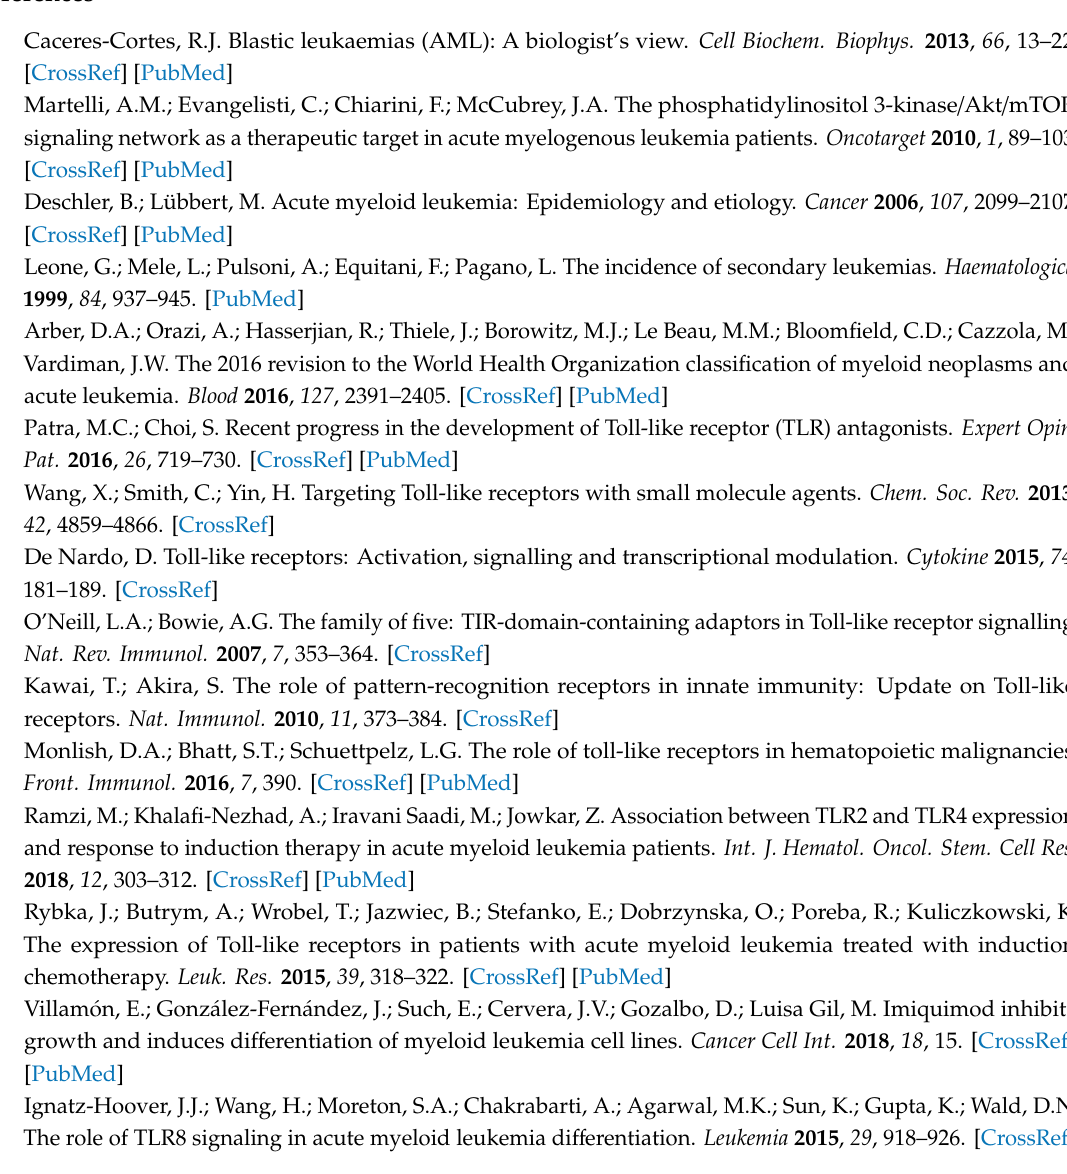
Figure S1: Patient survival dependent on response towards general TLR targeting, Figure S2: Basal mediator secretion levels for the 83 AML patients, Figure S3: Change in proliferation for the 10 test patients whose cells were exposed to di ff erent concentrations of TLR ligands, Table S1: Median concentration increase in the secretion of 19 soluble mediators as a result of targeting with four di ff erent TLR agonists, Table S2: Detailed information about the 83 AML patients included in the study, Table S3: GO-terms and their associated proteins that were found to be upregulated in TLR non-responders and TLR responders, respectively, Table S4: Overview over the mutational landscape of 38 consecutive AML patients, Table S5: Overexpressed genes in TLR non-responders and responders that can be linked with AML